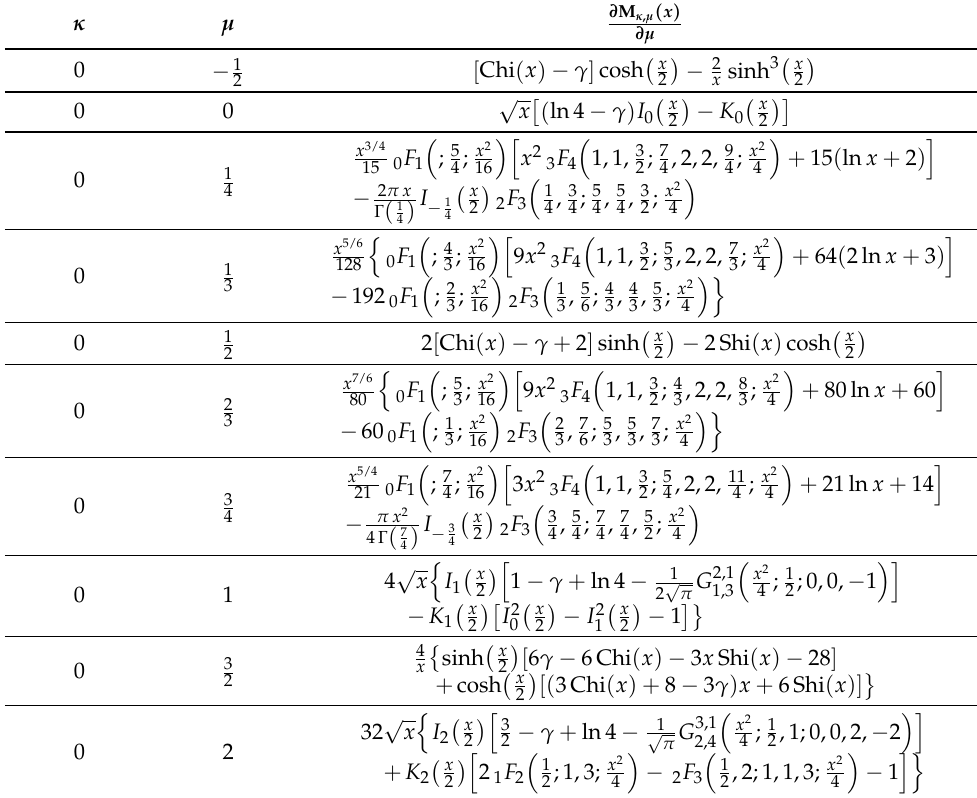
Table 4. Derivative of M κ , µ with respect to µ using